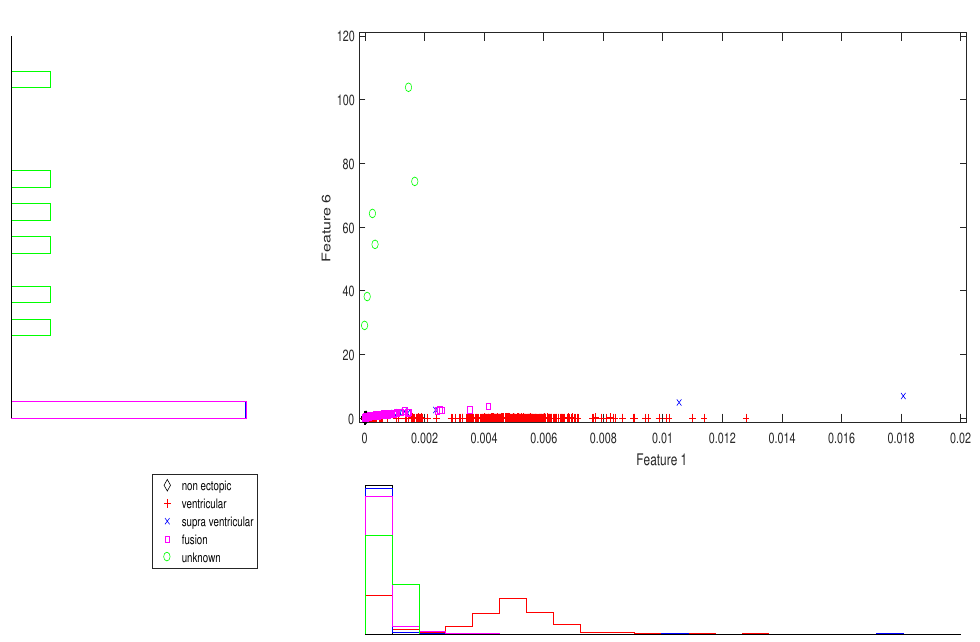
Figure 2. Scatter plot with marginal histogram for CUM2 (IMF1) vs. norm entropy (IMF1).